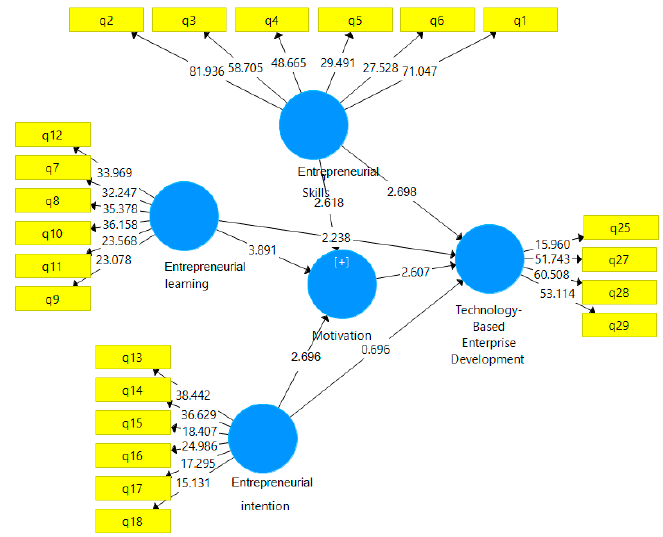
Figure 2. T-test results. Figure 2. t -test